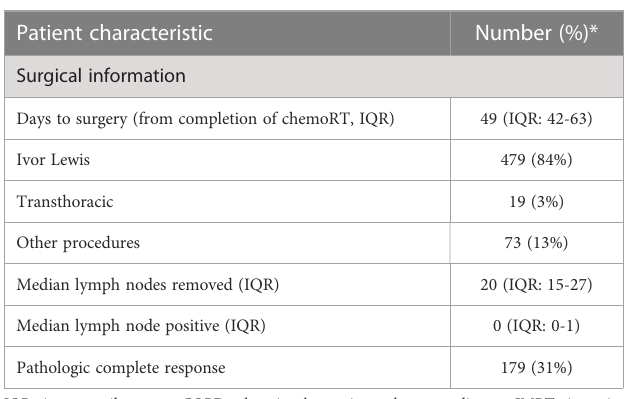
TABLE 1 Patient characteristics are demonstrated.